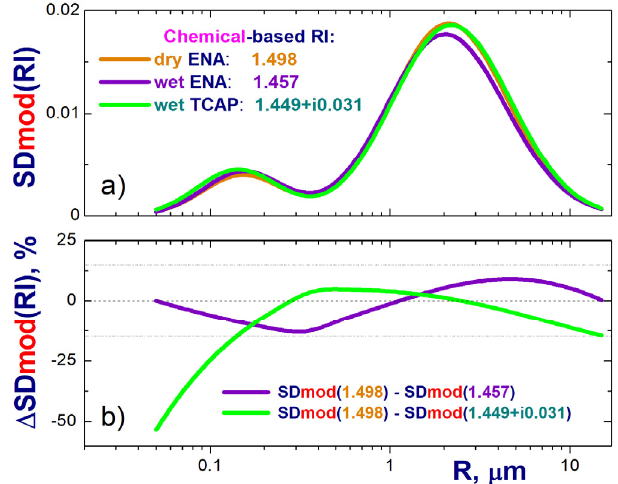
Figure 7. Example of model volume distribution (“SDmod”; µm 3 /µm 2 ) estimated from AOD measured at four CSPHOT wavelengths at the ENA site during summer and three assumed values of RI ( a ). The latter are obtained from the chemical composition data and define (1) the near-surface real RIs of non-absorbing particles obtained under dry (“dry ENA”) and ambient (“wet ENA”) conditions at the ENA site and (2) the vertically-integrated complex RI of both absorbing and non-absorbing particles obtained under ambient (“wet TCAP”) conditions during the TCAP campaign. ( b ) The corresponding relative differences of the model size distributions (“ Δ SDmod”). The dotted horizontal lines define an upper limit (± 15%) of the expected uncertainty of the model SD estimation asso- ciated with the RI assumptions.